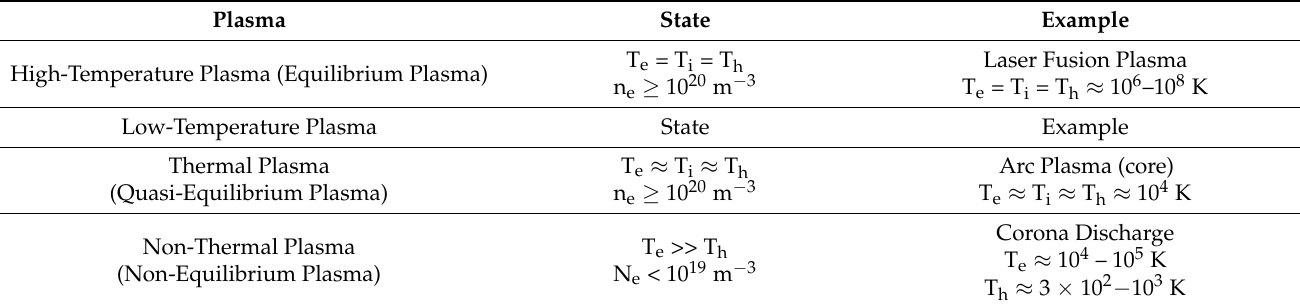
Table 3. Classifications of plasmas [152], with permission from Wiley,